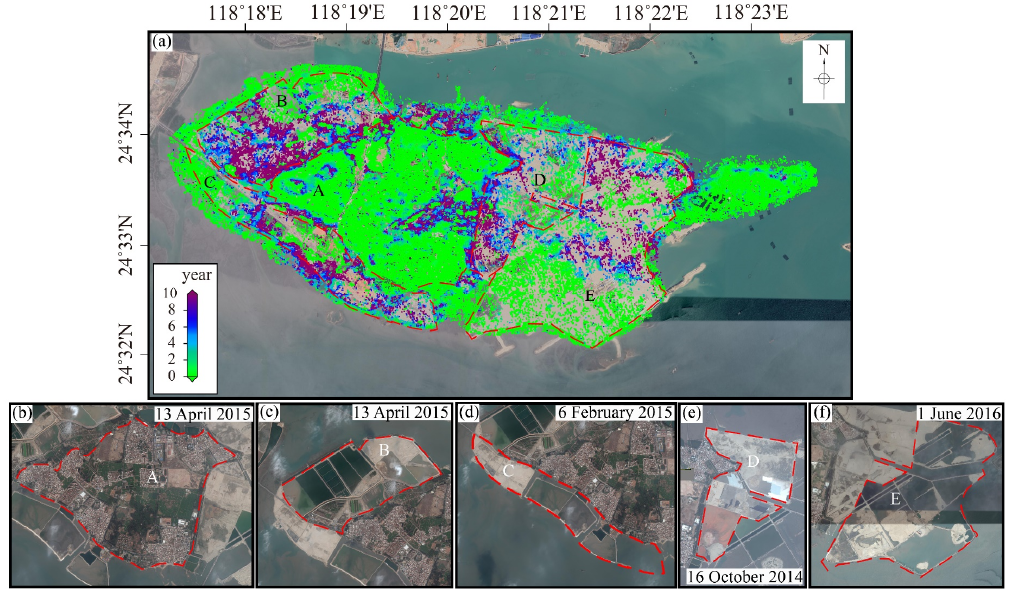
Figure 11. ( a ) The time needed for stabilization since the acquisition date (24 December 2019) of Dadeng Island and its reclamation areas: ( b ) optical image of area A acquired on 13 April 2015; ( c ) optical image of area B acquired on 13 April 2015; ( d ) optical image of area C acquired on 6 February 2015; ( e ) optical image of area D acquired on 16 October 2014; ( f ) optical image of area E acquired on 1 June 2016.